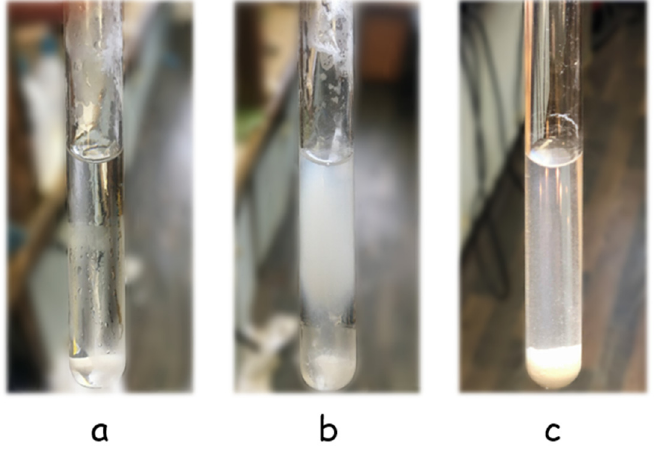
Figure 2. ( a ) Solubility of the monomer in ammonia, ( b ) 15 min after dissolution, and ( c ) 1 h after after dissolution.